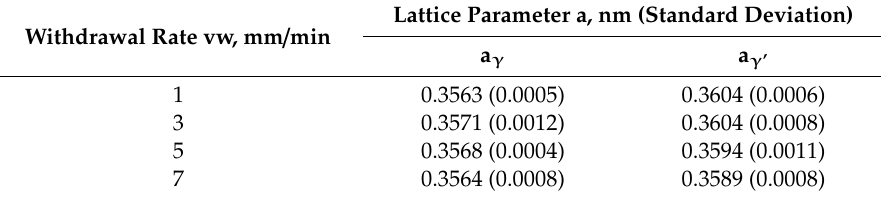
Table 4. Lattice parameter of the γ and γ ’